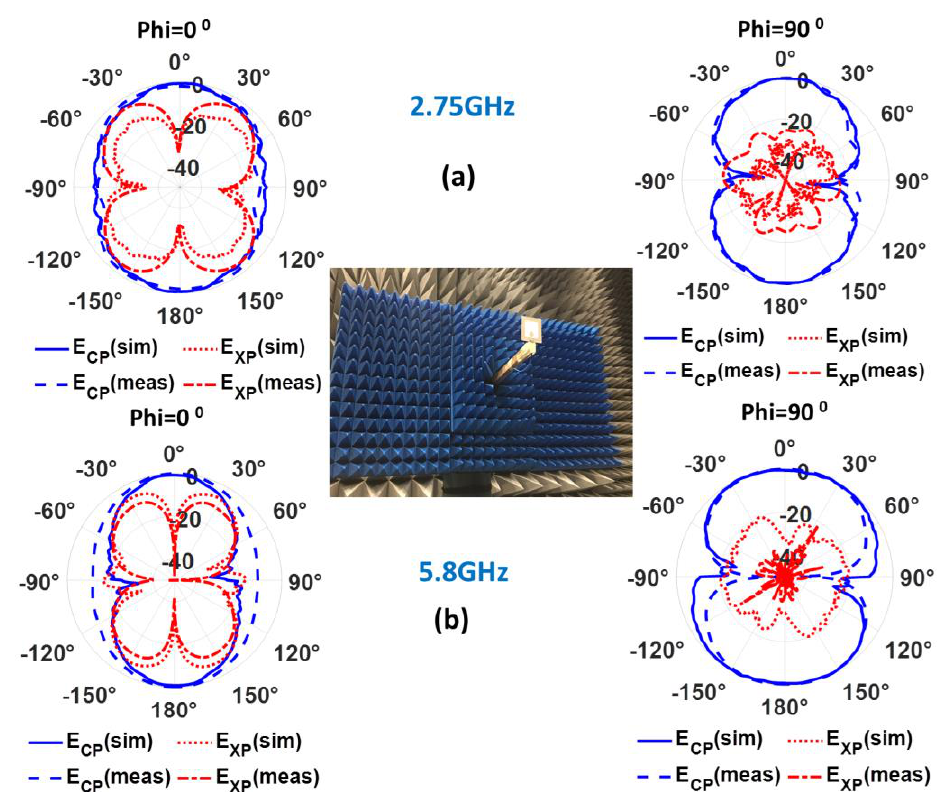
Figure 9. Radiation patterns obtained in measurement for the CPW-fed monopole antenna on ENrG’s Thin E-Strate respectively at 2.75 GHz ( a ) and 5.8GHz ( b ). The blue traces stand for copolarization (CP) and the red ones for crosspolarization (XP).